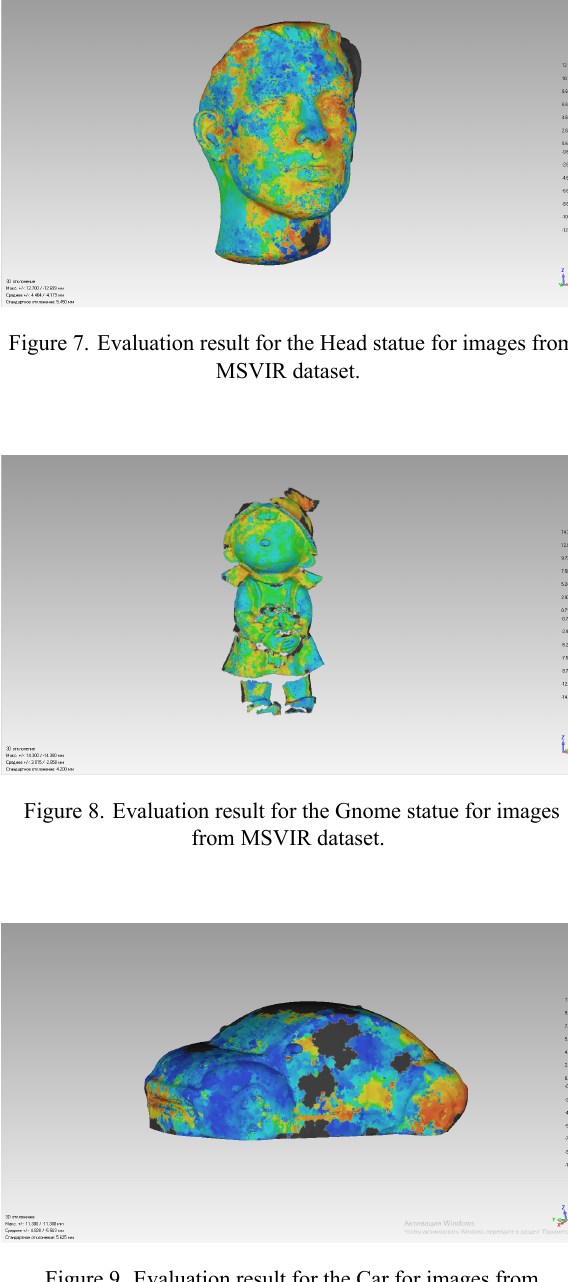
Figure 9. Evaluation result for the Car for images from ThermalPatches